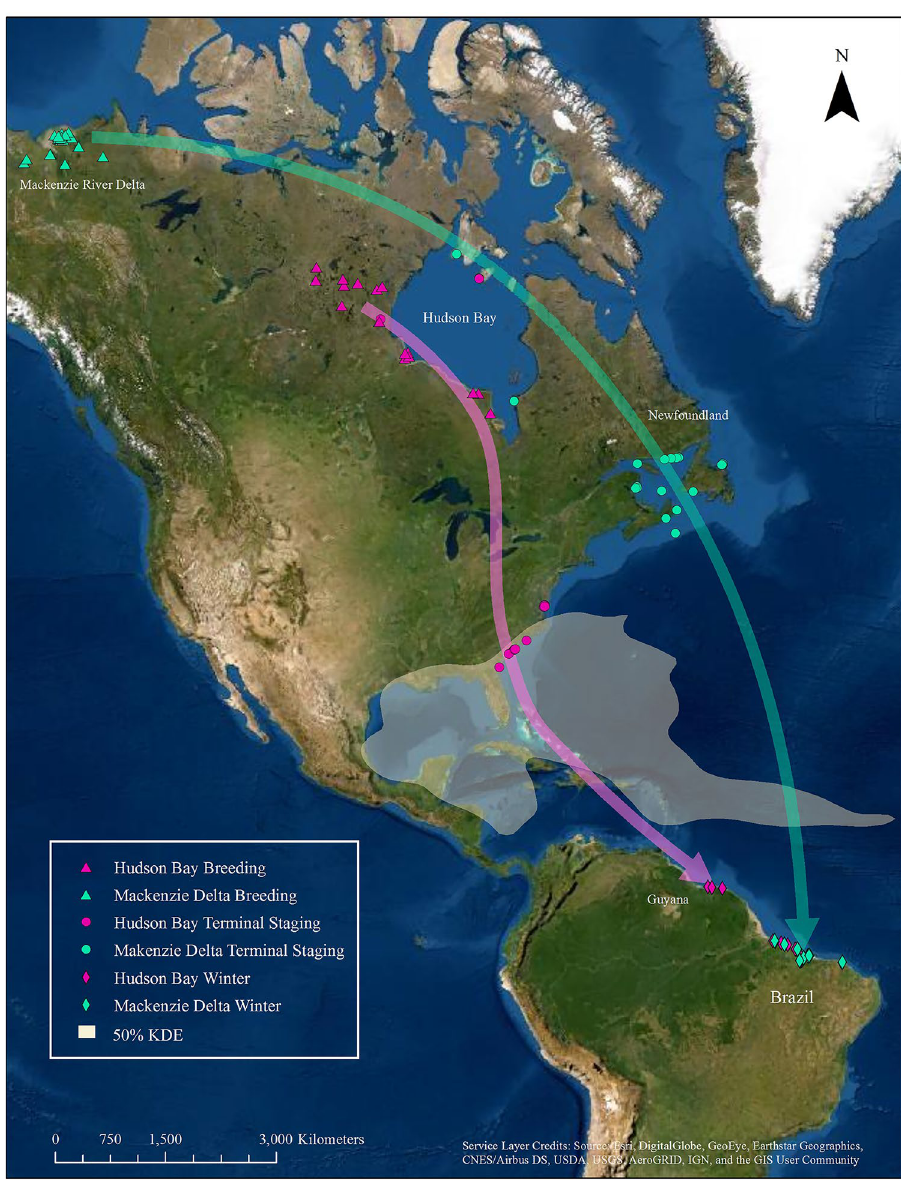
Figure 1. Stylized map of fall migration pathways for Mackenzie Delta and Hudson Bay populations and their overlap with the core area for tropical cyclone activity. Each triangle, circle, and diamond represent centroids for breeding territories, terminal staging locations, and wintering territories for each year and each individual. This figure was produced in ArcGIS 10.7.1 by an author: https:// www. esri.